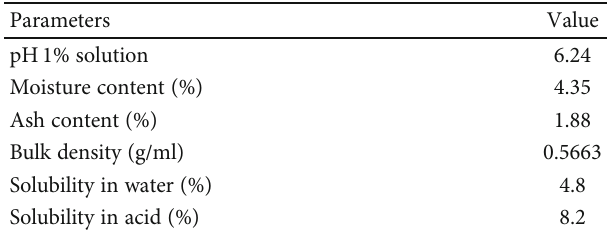
Table 2: Characteristics of activated carbon.